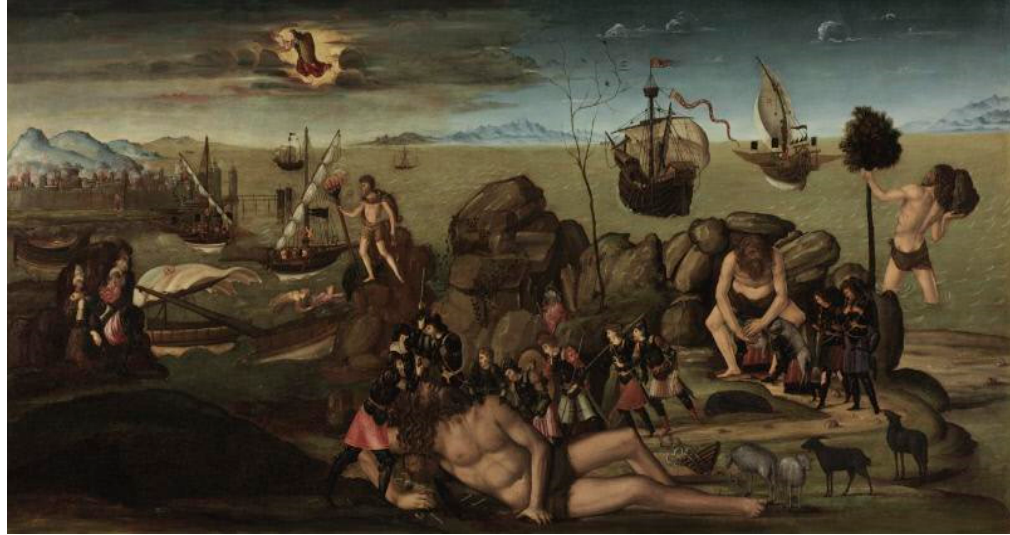
Figure 6. The Master of the Johnson Assumption of the Magdalen, The Adventures of Odysseus: The Blinding of Polyphemus (early 16th century), spalliera , tempera on panel, by permission of Vassar College.